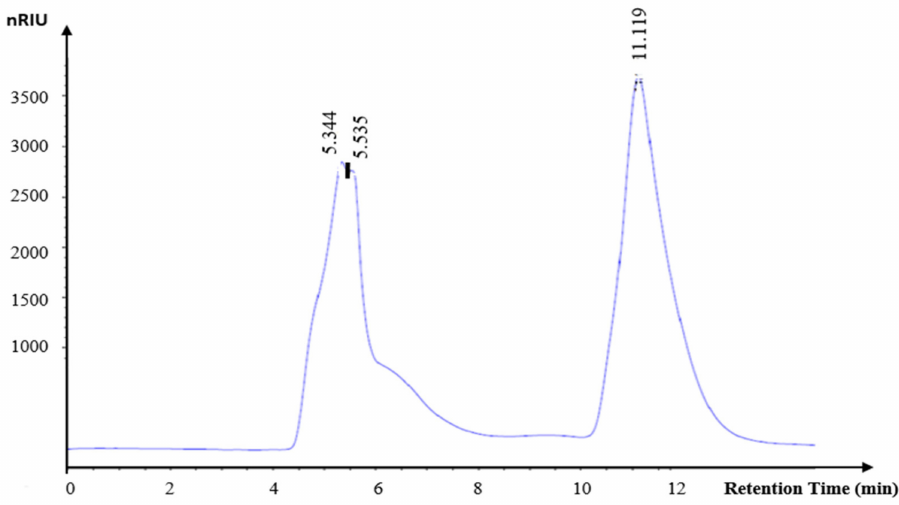
Figure 7. Gel filtration chromatographs of